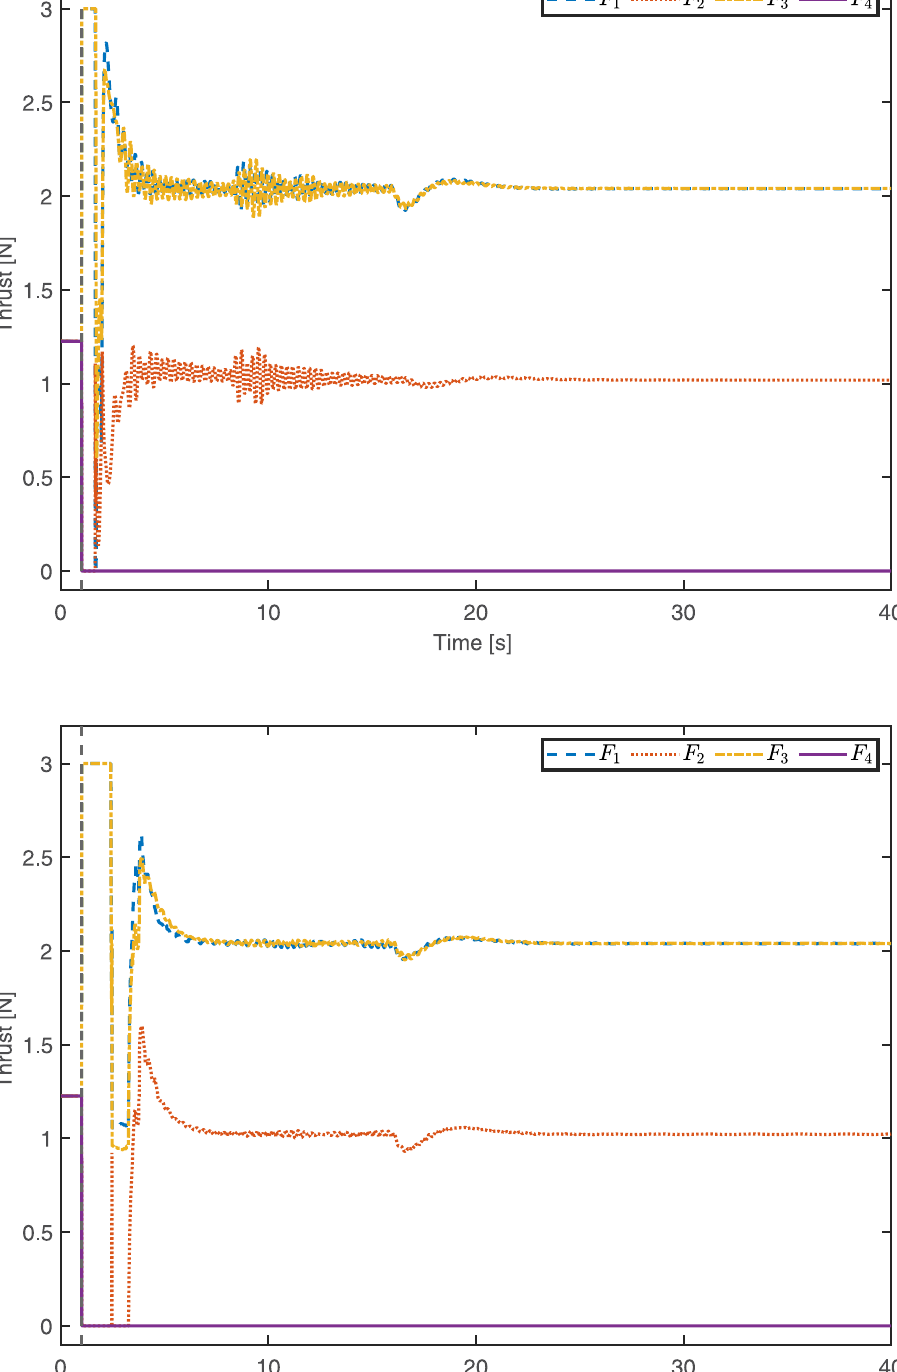
Fig 5. Motor thrusts of the quadrotor in case of One propeller failure. (a) Motor thrusts computed using LQI. (b) Motor thrusts computed using MPC.